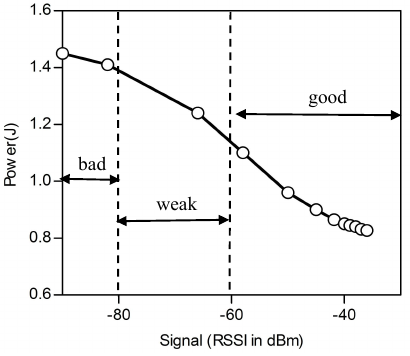
Fig. 4 . The average power consumption over different RSSIs Figure 5. The average power consumption over different RSSIs